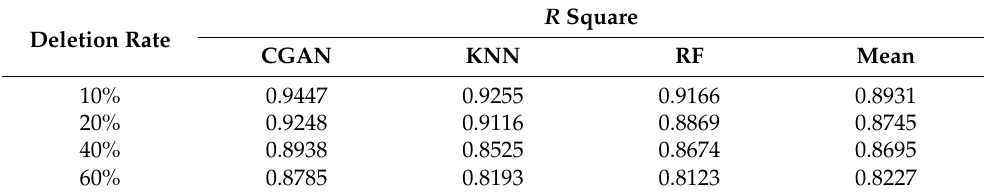
Table 3. R square comparison of reconstruction results of different models.